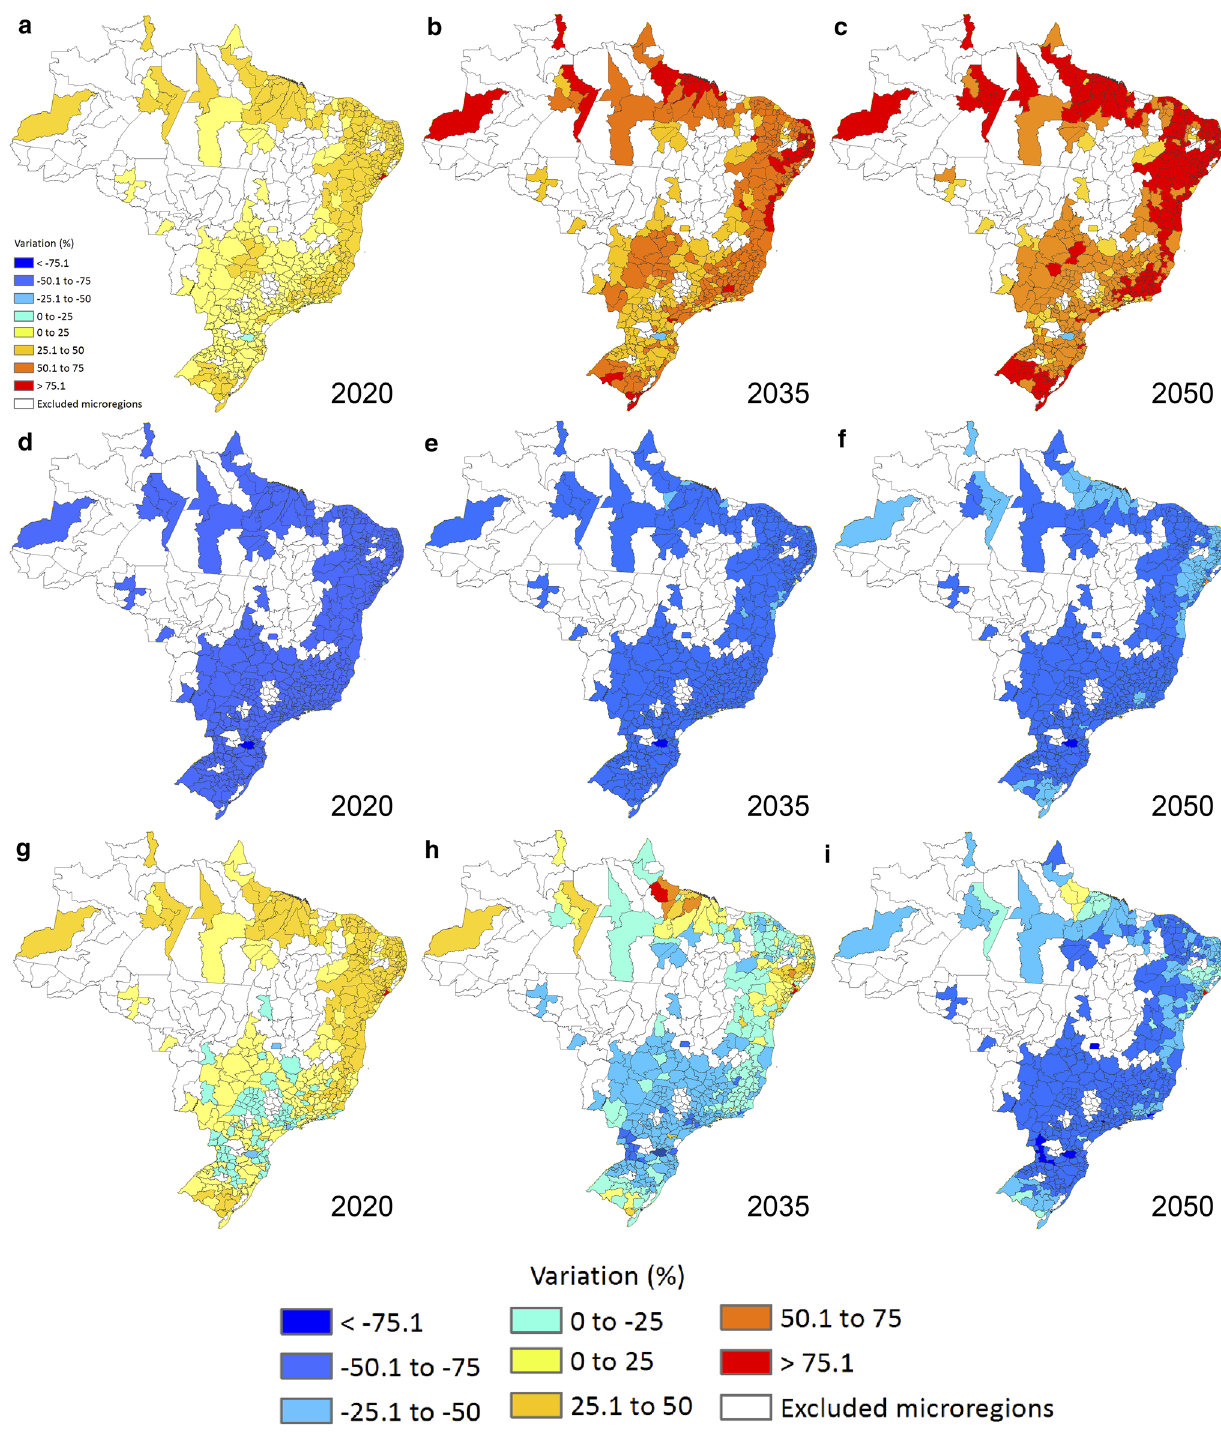
Fig. 7 Percentage variation of CO eq emissions related to estimated emissions in 2010 according to three different scenarios for Brazil. Per- 2 centage variation of CO eq emissions according to DAU trajectory ( a – c ). CO eq emissions reductions over DAU estimations considering a 2 2 hypothetical linear reduction pathway, in which the term r i , t in Eq. 4 becomes a constant equal to 0.26 (without indexations) ( d – f ). Reduc- tion pathways over DAU estimations according to our proposed framework ( g – i ). From a – c , there is no mitigation and, therefore, mitigation targets from Table 2 are not met. From d – i , mitigation burdens are set to achieve national mitigation goal a from Table 2. From d – f , mitiga- tion burdens are evenly distributed while from g – i they are accounted for according to our framework. “Excluded microregions ” indicate not statistically significant